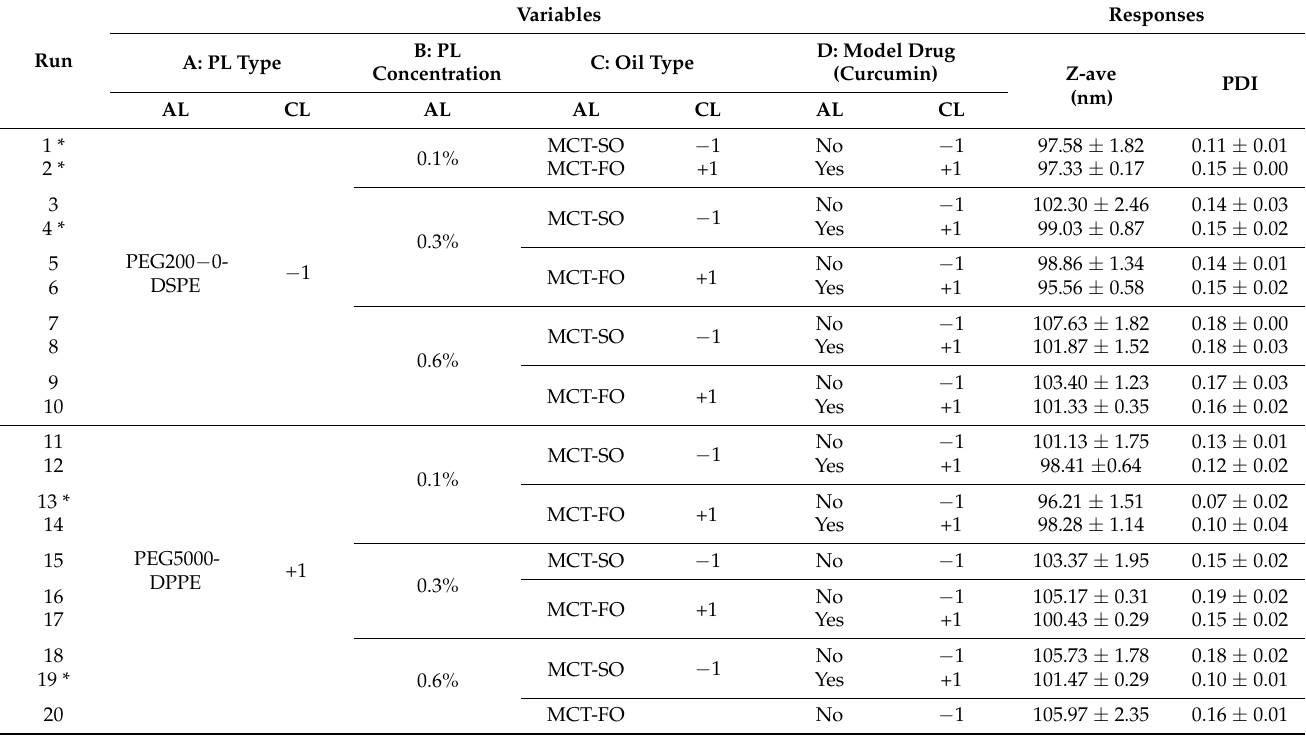
Table 3. D-optimal factorial design